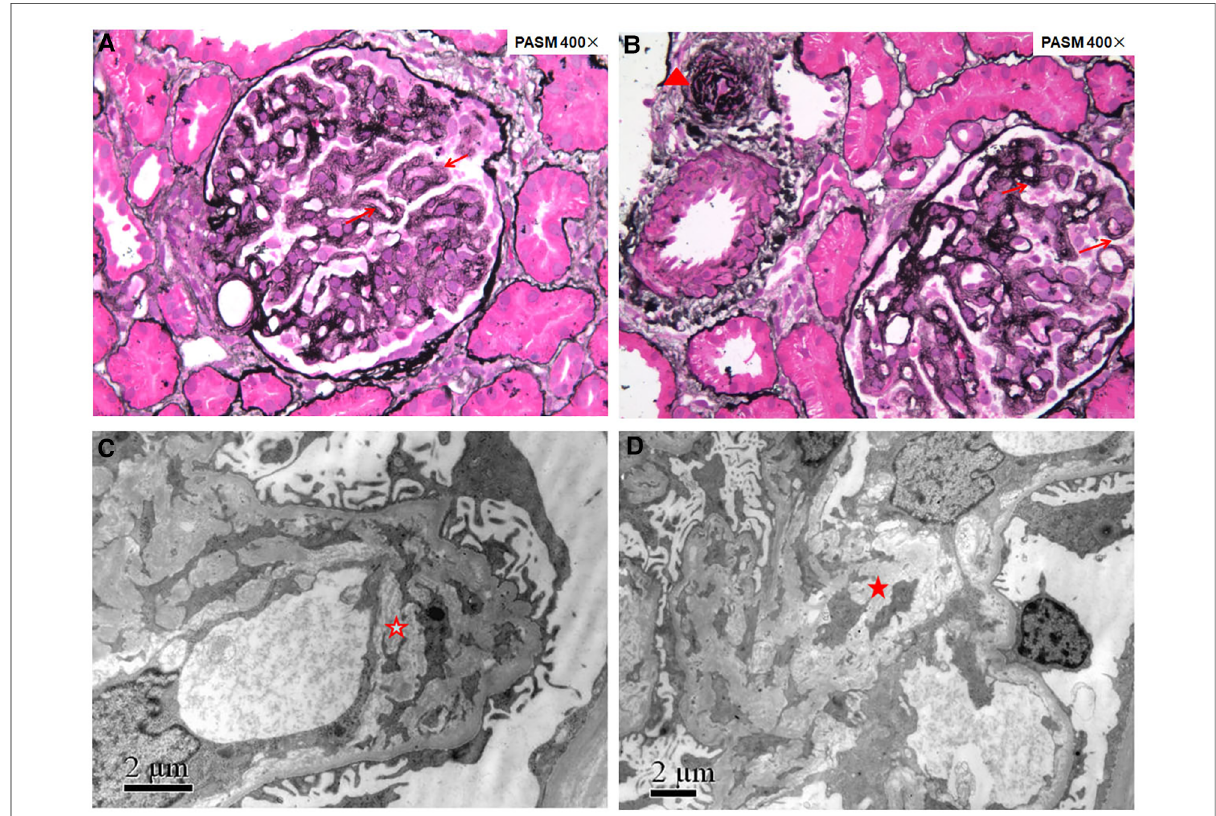
FIGURE 1 Renal pathology of patient 1 showing renal thrombotic microangiopathy. Fourteen glomeruli were sampled for light microscopy evaluation ( A,B ): the glomerular basement membrane thickened diffusely with double contours (red arrows); arterioles showed narrowed lumens with endothelial swelling and intimal onion-skin change (red triangle). Electron microscopy evaluation ( C,D ): the glomerular basement membrane thickened with subendothelial widening fi lled with electron-lucent fl uffy material, diffusely mesangial interposition along the inner layer of the glomerular basement membrane to form a double contour (red hollow star), and electron transparent mesangial lysis can be seen in the mesangial region (red solid